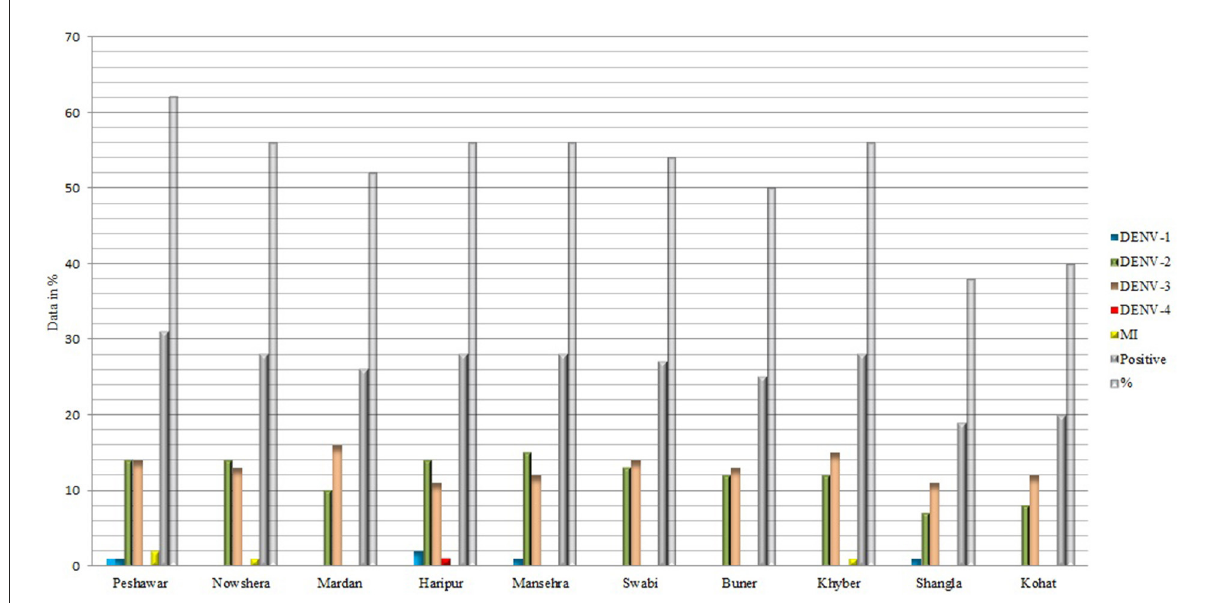
FIGURE4 Molecular investigation of DENV among dengue patients across the